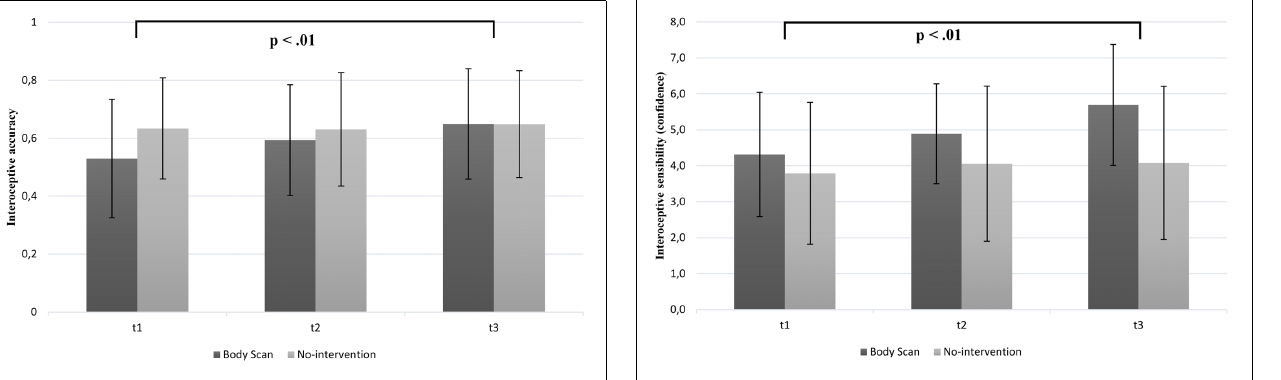
FIGURE 3 | Mean interoceptive accuracy scores as a function of group (BS vs. inactive group) and time (note: significant group differences at all time points are not marked here).